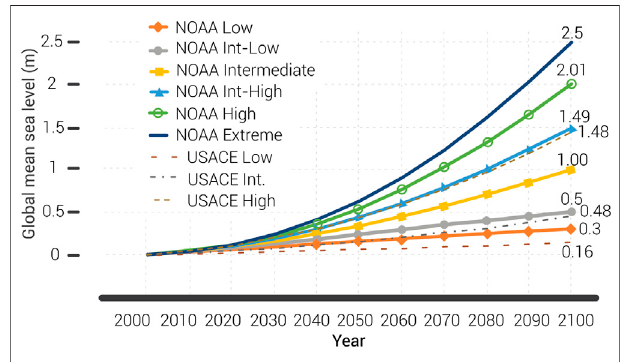
FIGURE 3 | Comparison between NOAA and USACE projections for SLR up to the year 2100 extracted from the tool developed by USACE.